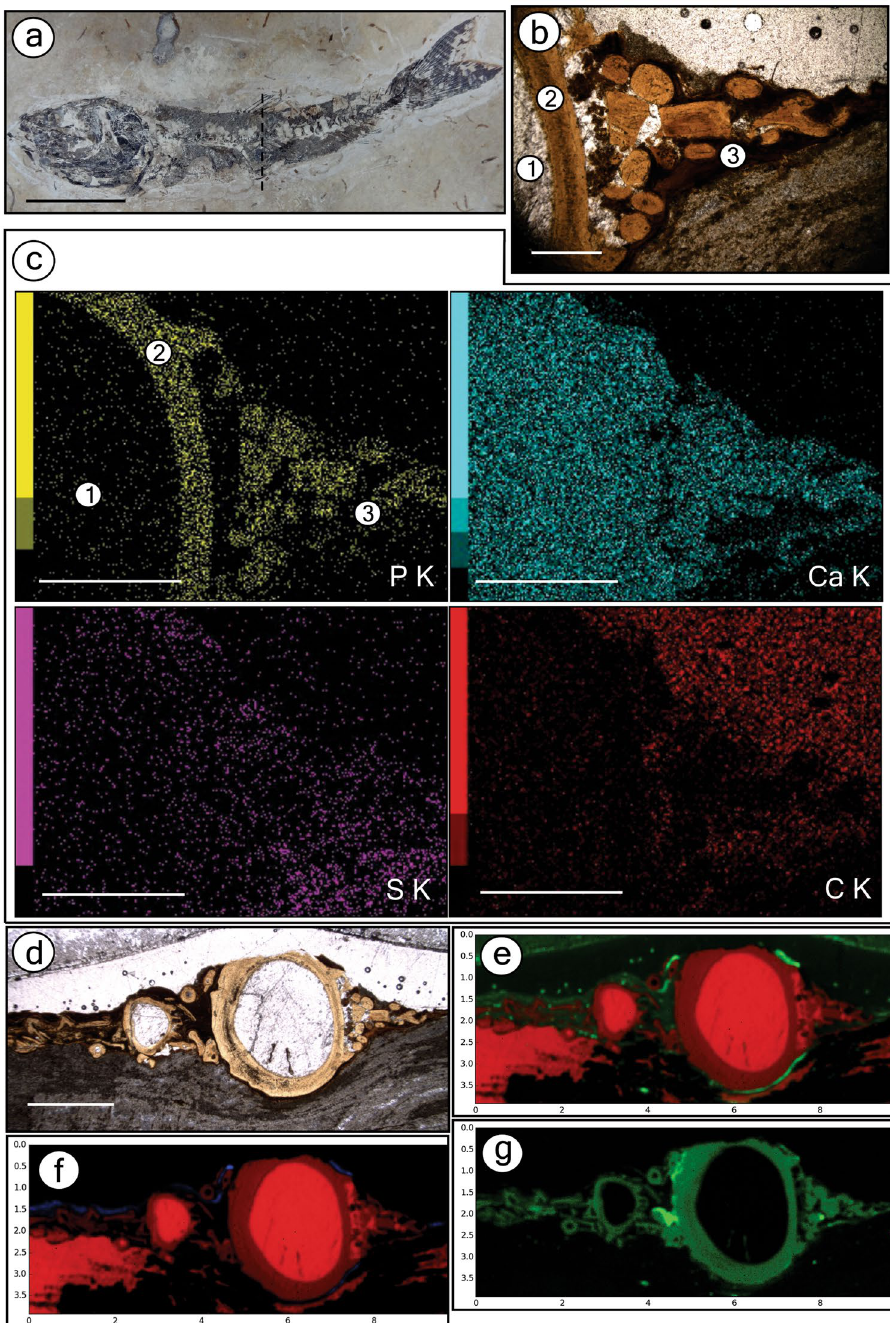
Figure 6. Geochemistry of the Crato Member fossil fish from GL. ( a ) Specimen GP/2E 9666 from grey limestones (GL). The approximate direction of thin section (in b ) extraction is marked by dashed line. ( b) Thin section (GP/L 16) of specimen in ( a ) showing calcite cement (1), vertebrae (2), and soft- tissues (3). ( c ) EDS maps of elemental distribution over areas (1–3) selected in ( b) . ( d) Area mapped by SR- µ XRF of the thin section GP/L 16. ( e – g) SR- µ XRF maps. ( e) Ca – red, Fe – green. ( f ) Ca – red, Cu – blue. ( g ) Zn. Colour brightness is proportional to element concentration, and both map horizontal and vertical scale axes are in mm. Elemental maps of all elements (except for Zn) are in Supplementary Figure 9. Scale bars: ( a) – 1.5 cm; ( b) – 0.5 mm; ( c) – 1 mm; ( d) – 2